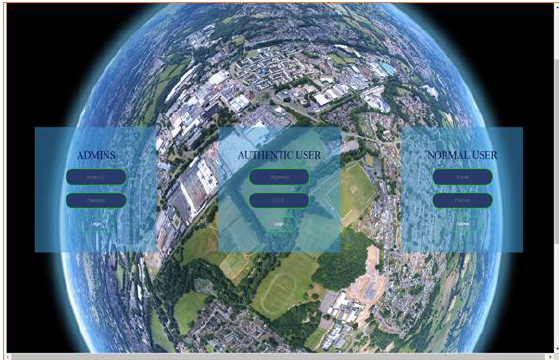
Figure 2. Login Sections for different kind of users